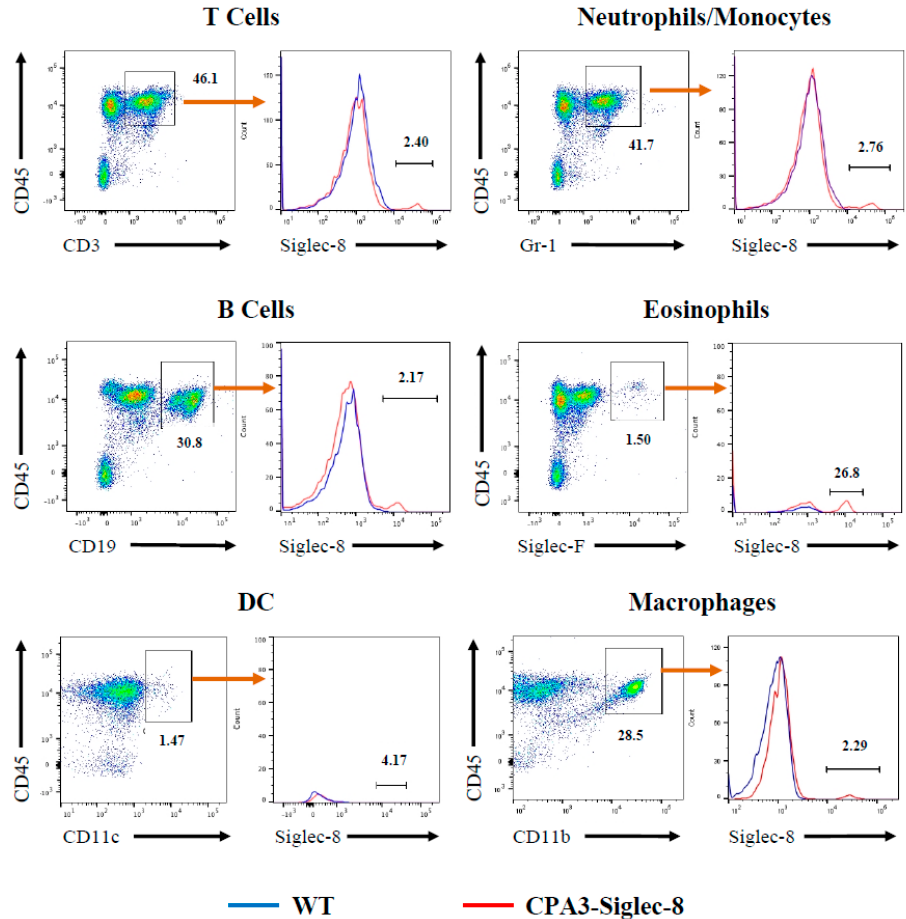
Figure 5. Minimum or no surface expression of Siglec-8 on leukocytes other than mast cells and basophils. Splenocytes were collected from WT and CPA3-Siglec-8 mice and analyzed for Siglec-8 expression after gating to CD45 + and specific cell markers, CD3 for T cells, CD19 for B cells, CD11c for dendritic cells (DC), Gr-1 for neutrophils and monocytes, Siglec-F for eosinophils, and CD11b for macrophages. The numbers are percentages of indicated cell populations. Shown are representative plots of three independent experiments.